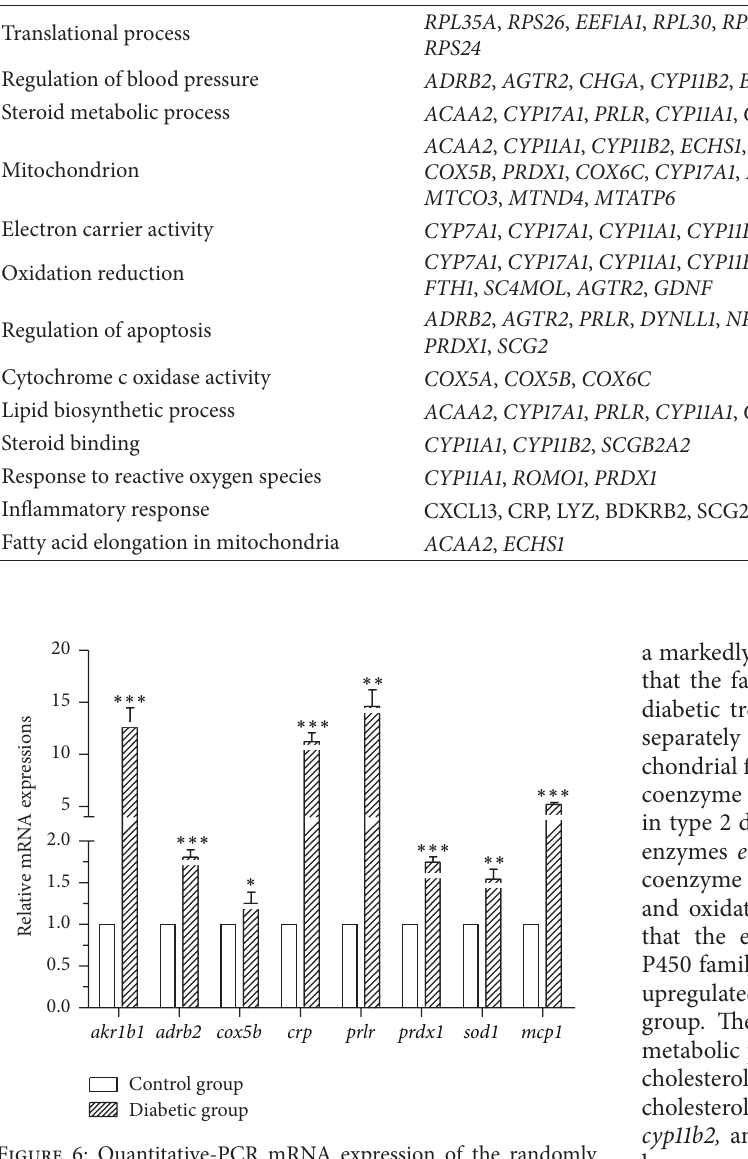
Figure 6: Quantitative-PCR mRNA expression of the randomly selected genes from differentially expressed genes in liver tissues of control and diabetic tree shrews. Significance between two groups; ∗ 𝑃 < 0.05 , ∗∗ 𝑃 < 0.01 , and ∗∗∗ 𝑃 < 0.001 .